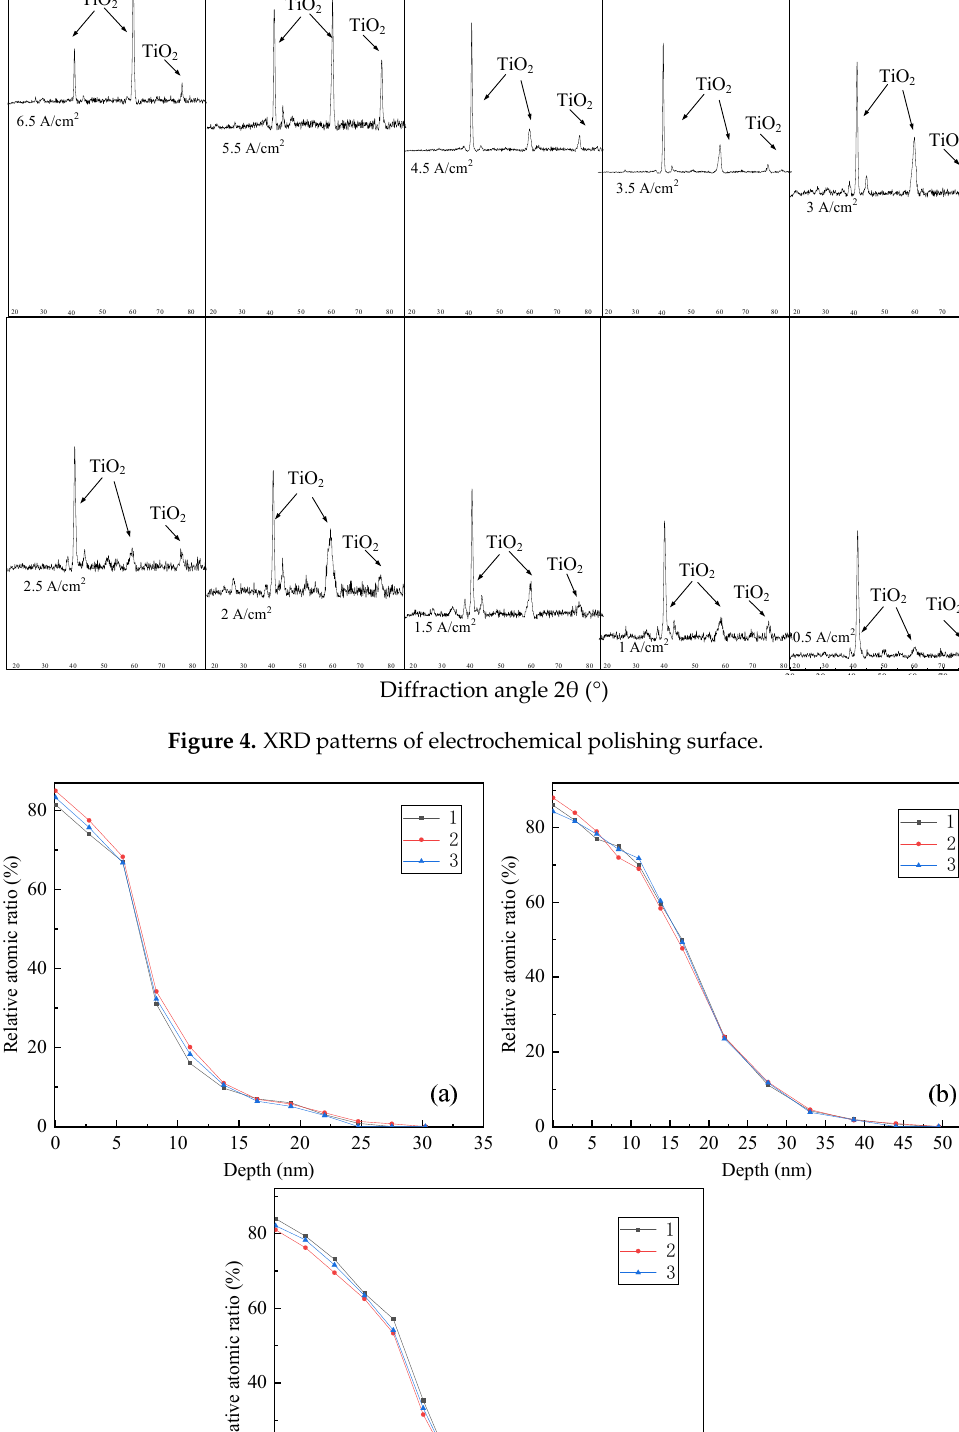
Figure 5. Distribution of oxygen on NiTi alloy surface along depth direction: ( a ) 1 A/cm 2 , ( b ) 3 A/cm 2 and ( c ) 6.5 A/cm 2 . Table 2. The thickness of oxide film on the electrochemical polishing surface.